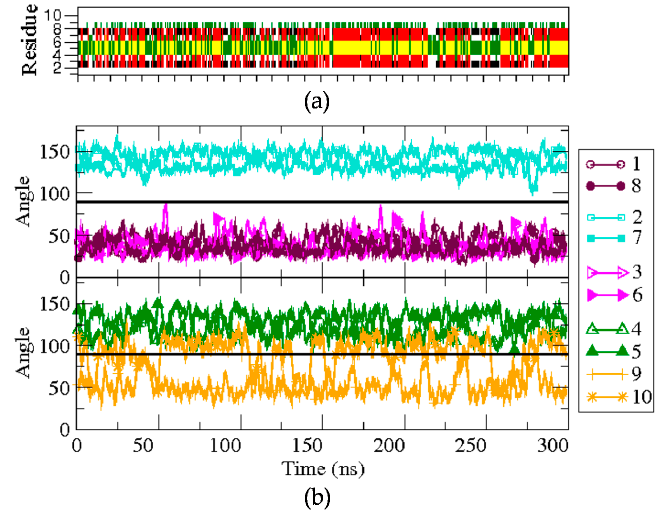
Figure 3. Structural characterization of the BPC194 simulation. ( a ) The secondary structure as a function of time is calculated by DSSP. The colors denote the β -sheet (red), the turn (yellow), β -bridge (black), bend (green), and random coil elements (white/empty). ( b ) Time evolution of the angle formed between the normal vector to the backbone plane and a vector representing each of the side chains.